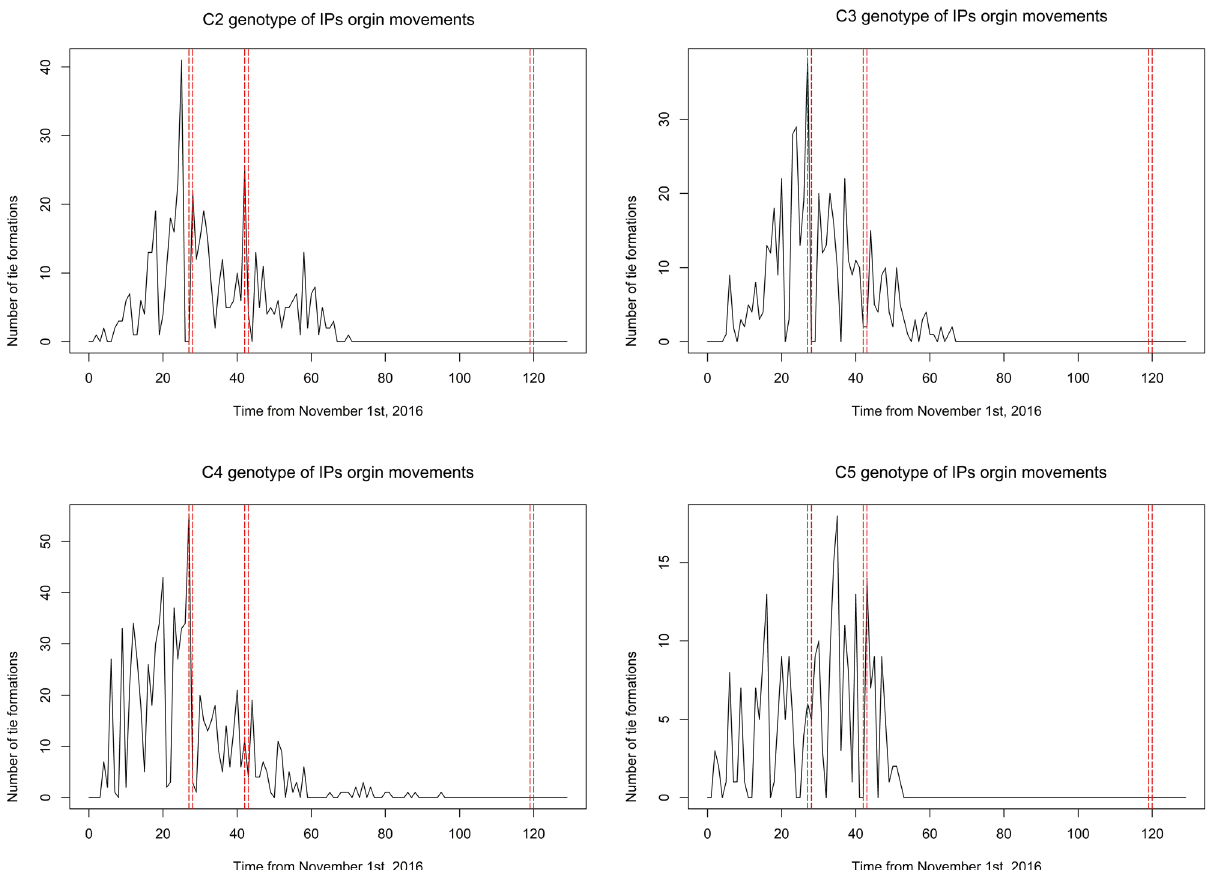
Figure 3. The temporal trends of tie formations with HPAI H5N6 infected premises (IPs) via potentially contaminating vehicle movement that was presumed to infectious duration of one day; C2(top left), C3(top right), C4(bottom left) and C5(bottom right). Red dashed vertical lines represent the period of standstills; First standstill was enforced on ten municipalities starting from November 28th, 2016 to November 29th,